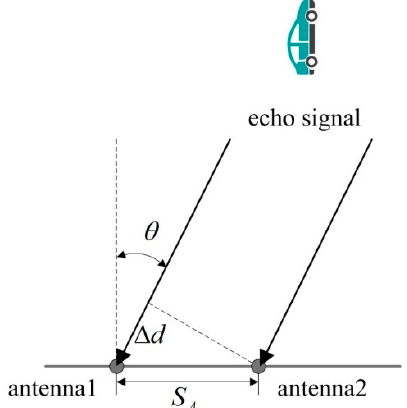
Figure 4. Principle of the radar angle measurement.